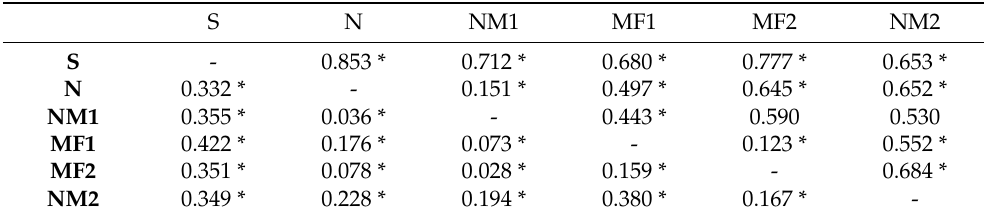
Table 4. Differentiation between the six Liolaemus monticola chromosomal races (S: Southern; N: Northern; NM1: Northern Modified 1; MF1: Multiple Fissions 1; MF2: Multiple Fissions 2; NM2: Northern Modified 2). Above the diagonal, F ST values obtained from chromosome “alleles”; below the diagonal cytb sequences data *: p < 0.05.